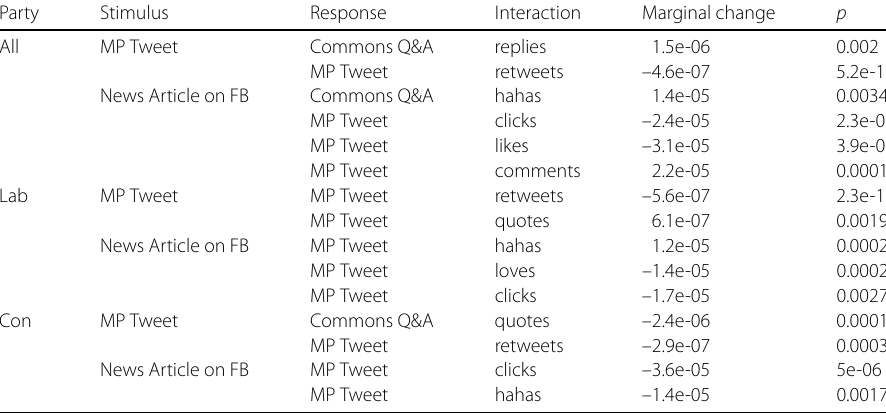
Table 2 Marginal change in word transfer between domains associated with logged counts of different kinds of interactions. Linear regression coefficients are the magnitude of the marginal change coefficient. Only statistically-significant interactions are included here; see Supporting Information for a table including all interactions Party Stimulus Response Interaction Marginal change p All MP